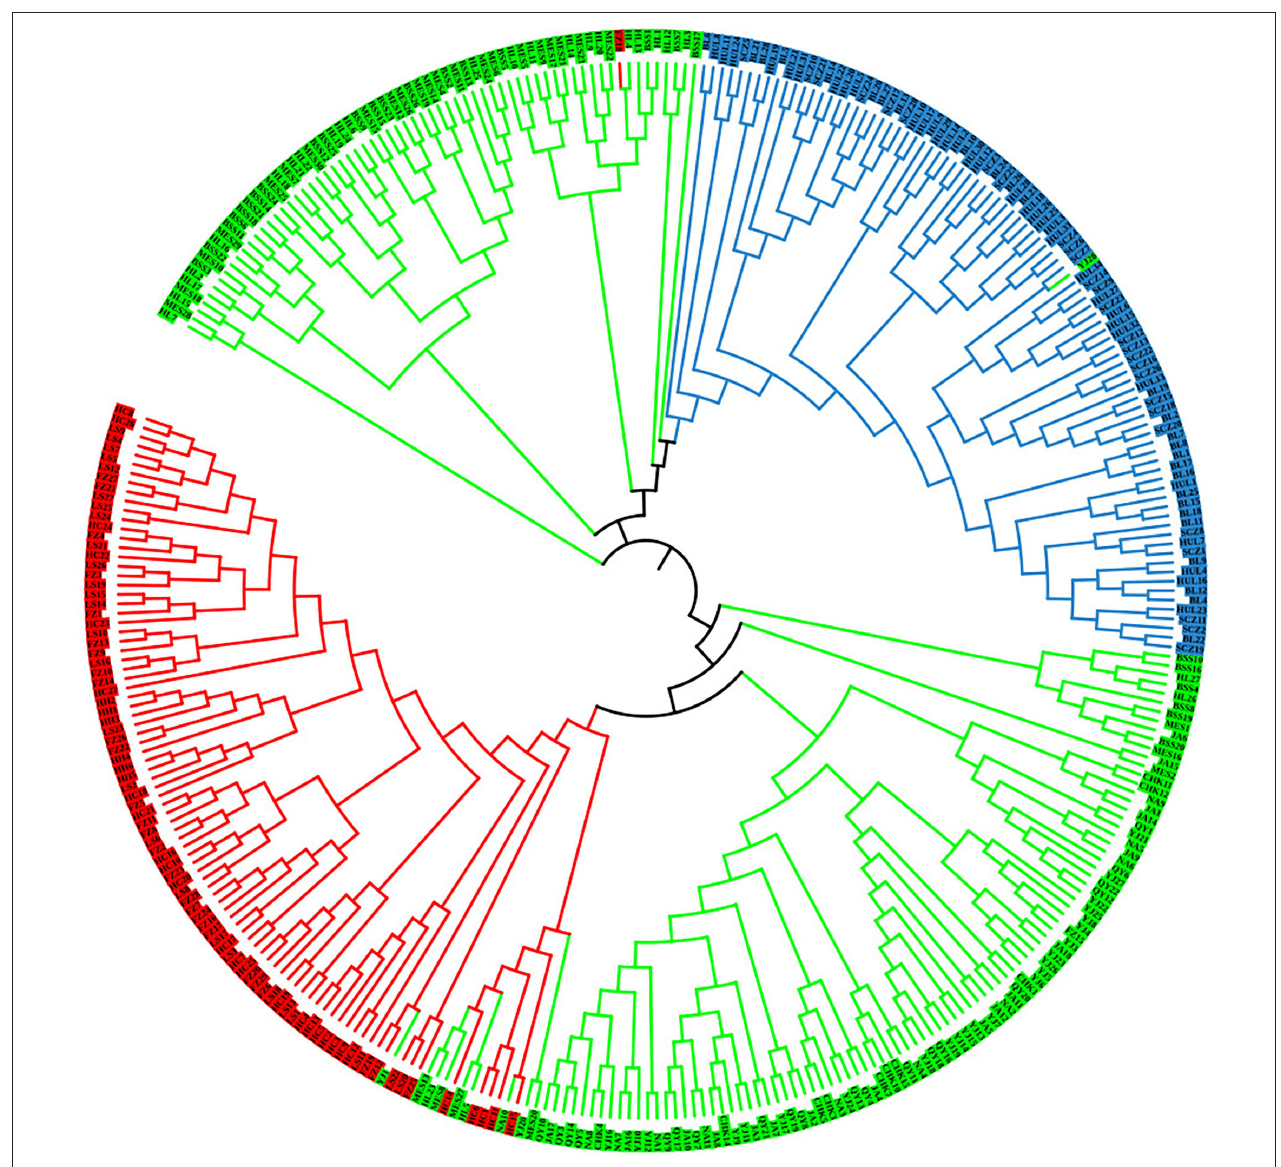
FIGURE 6 | Neighbor-joining tree of 343 J. mandshurica individuals (HH: Heihe; HC: Hunchun; FZ: Fangzheng; LS: Liangshui; NA: Ningan; CHK: Caohekou; JA: Jian; QY: Qingyuan; YJ: Yongji; SCZ: Sanchazi; BL: Boli; HUL: Hulin; HL: Helong; BSS: Baishishan; and MES: